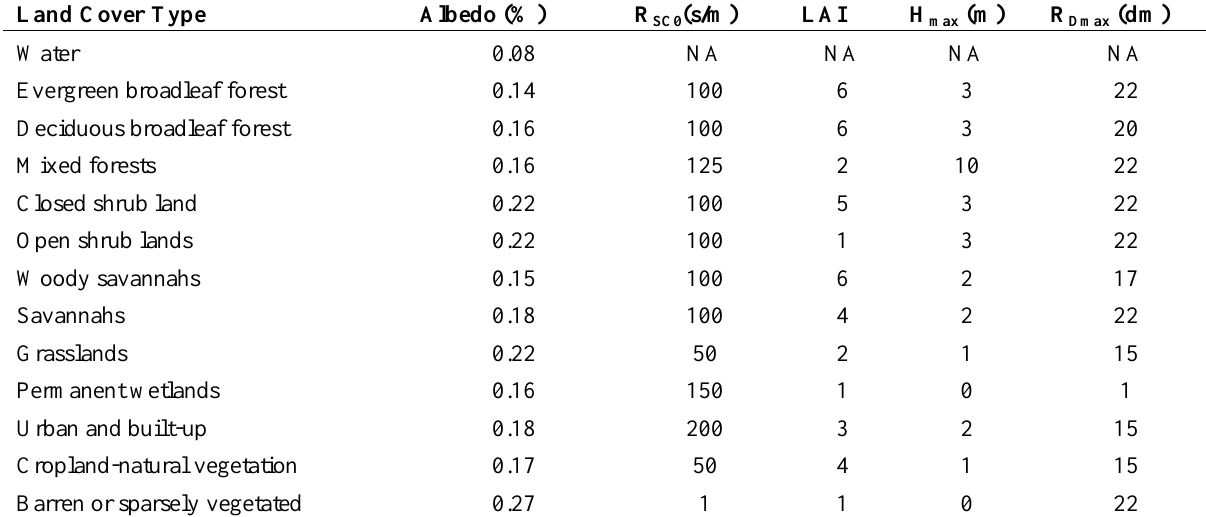
Table 1. Adopted Albedo, LAI, R Geosphere-Biosphere Programme (IGBP) land cover type. NA = Not Applicable. (Source: